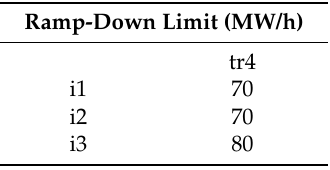
Table A10. Ramp-down limit of unit i (MW/h): ramp_down( i ).